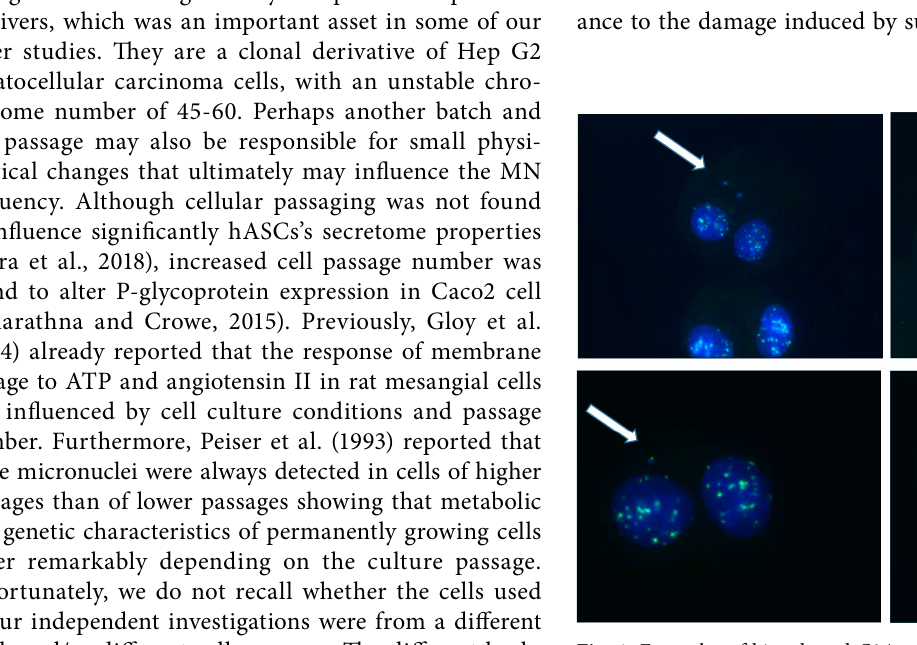
Fig. 1. Examples of binucleated C3A cells with micronuclei follow- ing FISH staining. Centromere positive cells are at the